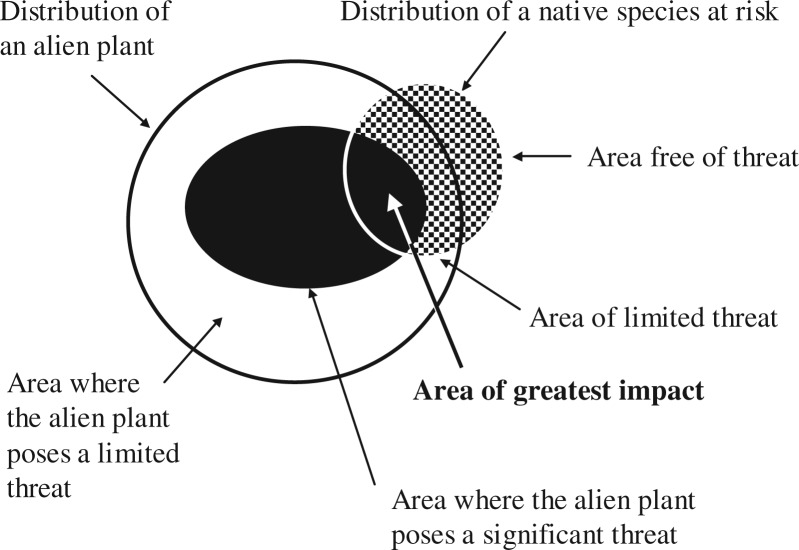
An example showing the spatial relationship and nature of the threat between the ranges of an alien and a native plant (reproduced from Downey 2010, from Invasive Plant Science and Management, with the permission of Allen Press Publishing Services).